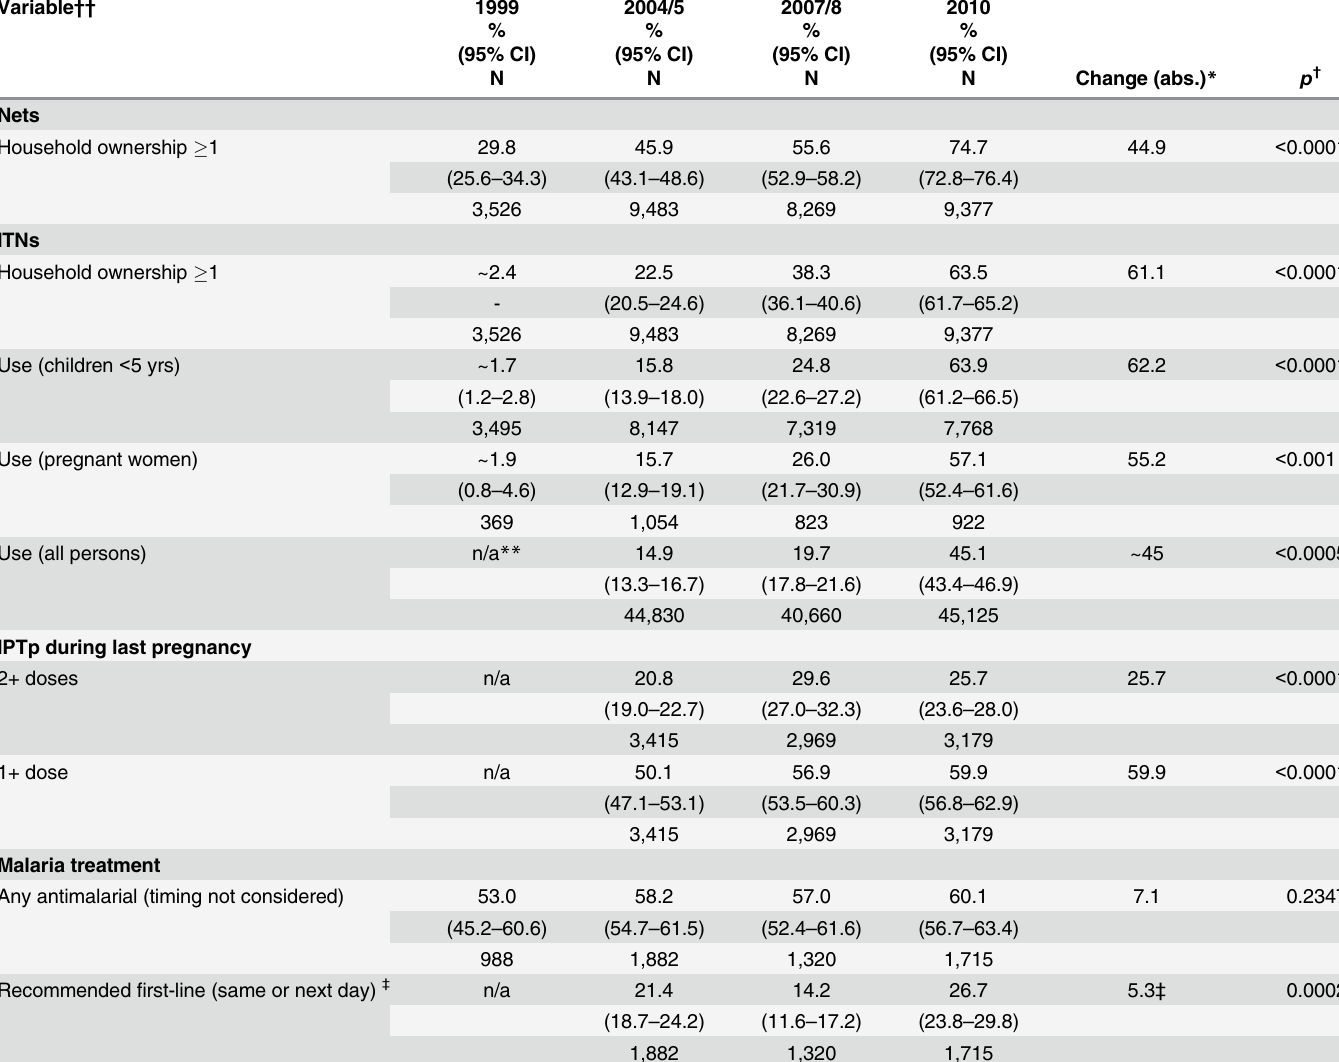
Table 1. Trends in malaria intervention coverage indicators, Mainland Tanzania, 1999 –